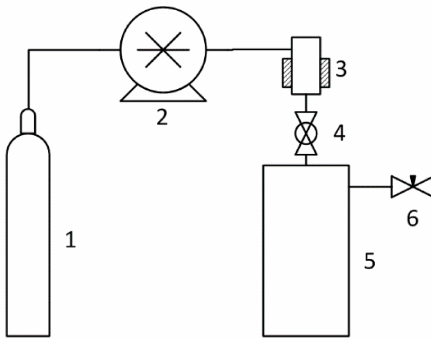
Figure 1. The scheme of the apparatus for rapid expansion of supercritical suspensions: 1 is the CO 2 source, 2 is the CO 2 pump, 3 is the suspension chamber, 4 is the 1.5 mm spray nozzle, 5 is the atmospheric pressure precipitation vessel, and 6 is the